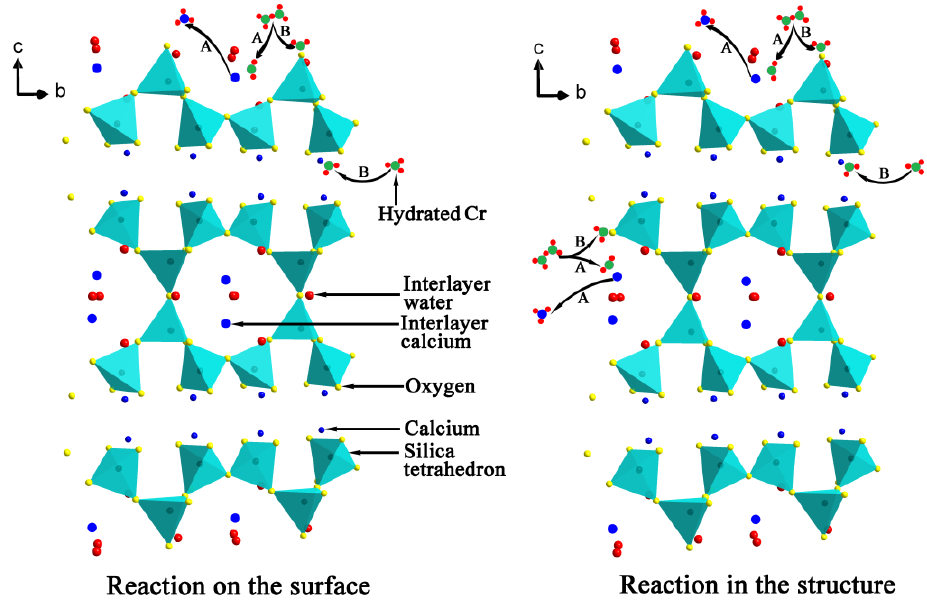
Figure 15. Schematic presentation of the adsorption mechanism of Cr(VI) by tobermorite: (A) ion exchange reaction; and (B) immobilization effect.